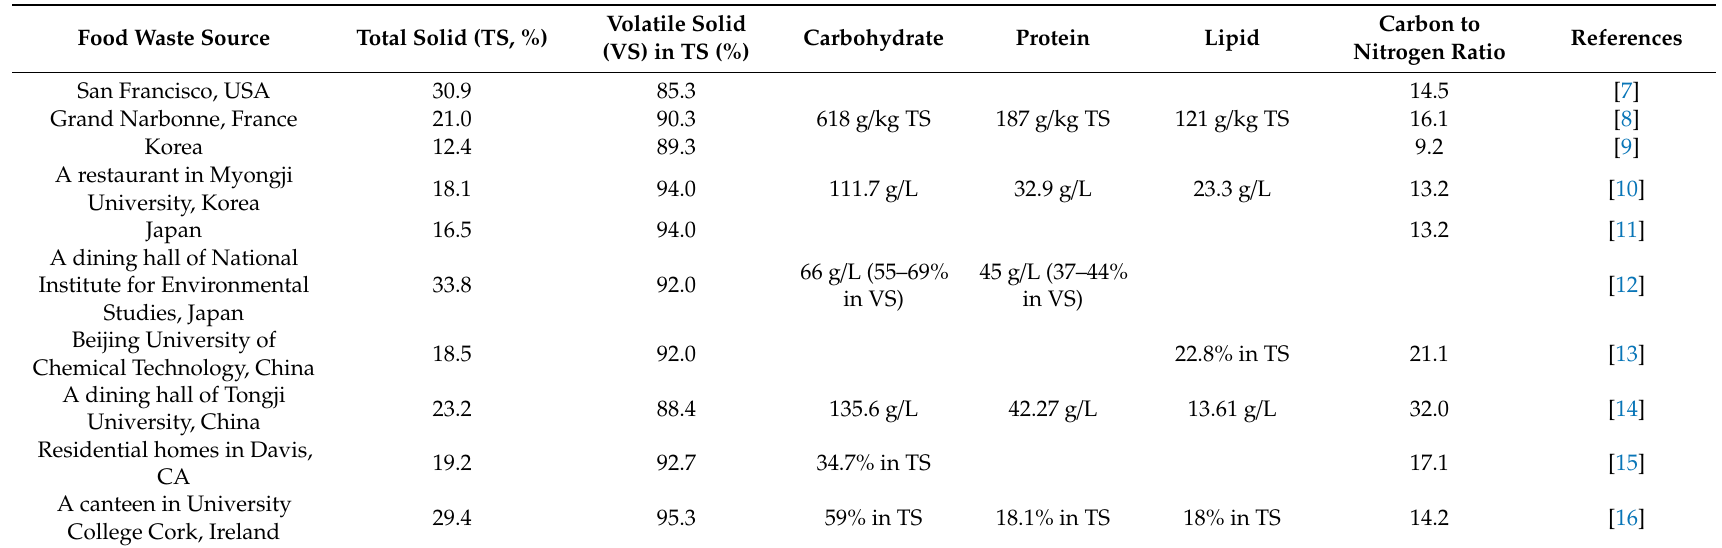
Table 1. Characteristics of food waste reported in